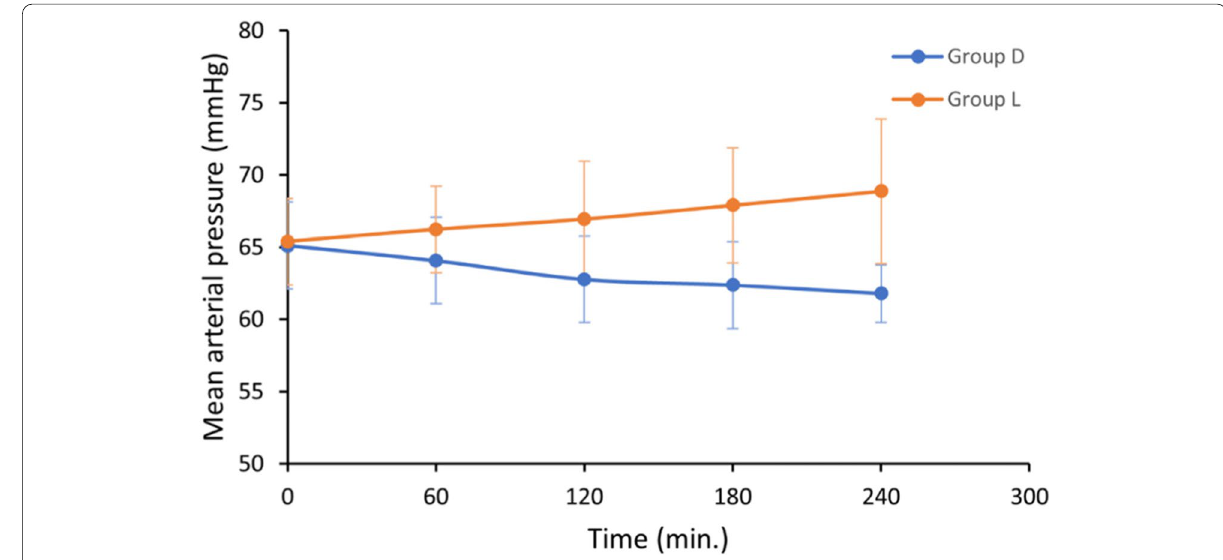
Fig. 2 Comparison of post-operative heart rate for the two groups